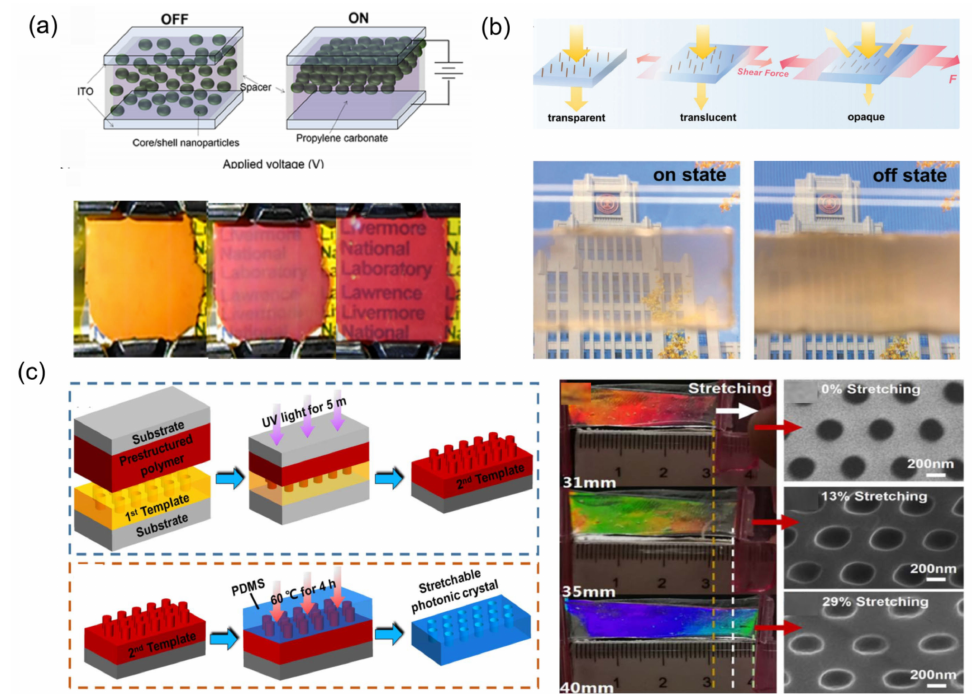
Figure 5. Mechanoresponsive smart windows with dynamic control of interface parameters: ( a ) colloidal particle spacing [41] Copyright 2018, American Chemical Society, ( b ) colloidal par- ticle direction [42] Copyright 2021, John Wiley and Sons, ( c ) spacing and shape of hole [17] Copyright 2019, Iop Publishing (Bristol,